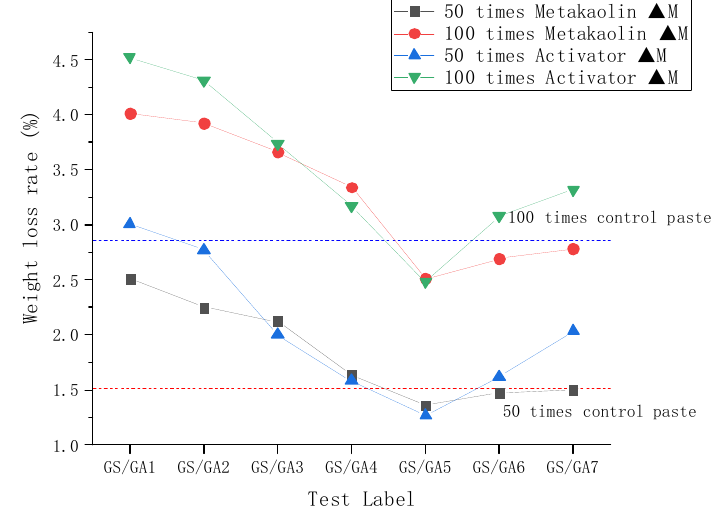
Figure 6. Weight loss rates after 50/100 times of GS/GA and cement control pastes.